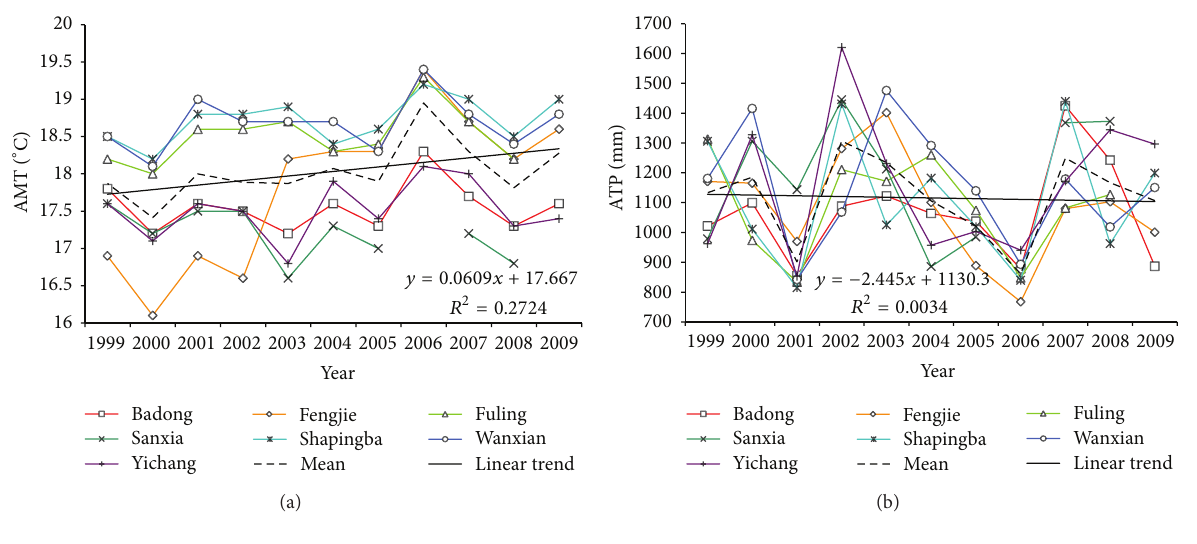
Figure 7: AMT and ATP trends in weather stations during the